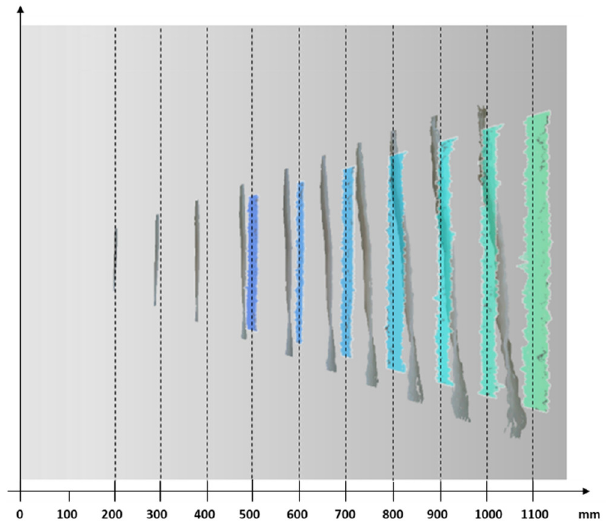
Figure 3. The qualitative evaluation of the error introduced in measuring a flat surface, and comparison between SR300 (grey point clouds) and D415 (colored point clouds) models.